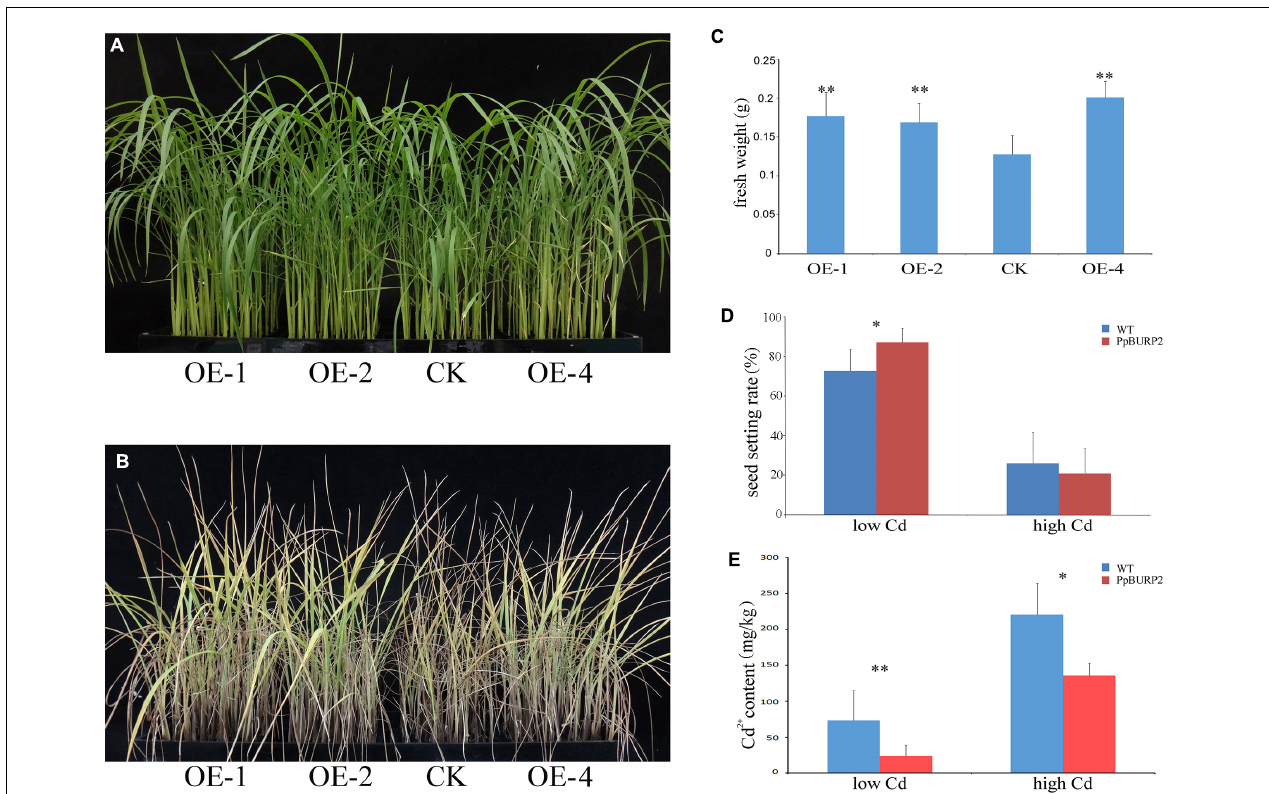
FIGURE 5 | Ectopic expression of PpBURP2 enhanced the tolerance of rice to cadmium stress. PpBURP2 transgenic rice plants and WT plants were cultured in 96-well plates and treated with 750 mM CdCl 2 for 10 days. Representative images of the WT and transgenic seedlings before (A) and after (B) , and fresh weight (C) . (D) Survival rate of PpBURP2 transgenic plants and WT plants after different concentrations of CdCl 2 treatment. (E) Cd 2 + content in leaves of the WT and transgenic plants at both low and high concentration treatment. The error bars indicate SEs based on three replicates. ∗ p < 0.05 and ∗∗ p <